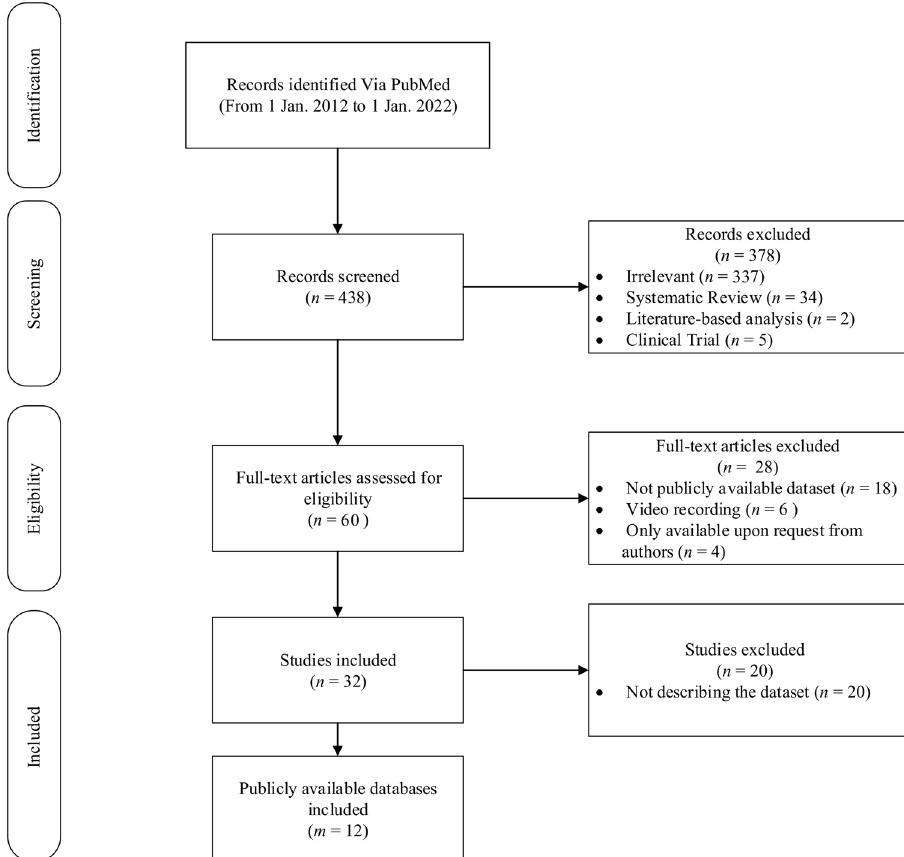
Fig. 1 Flow chart of study identi fi cation, inclusion and exclusion criteria. Presentation of the literature search and selection procedure together with